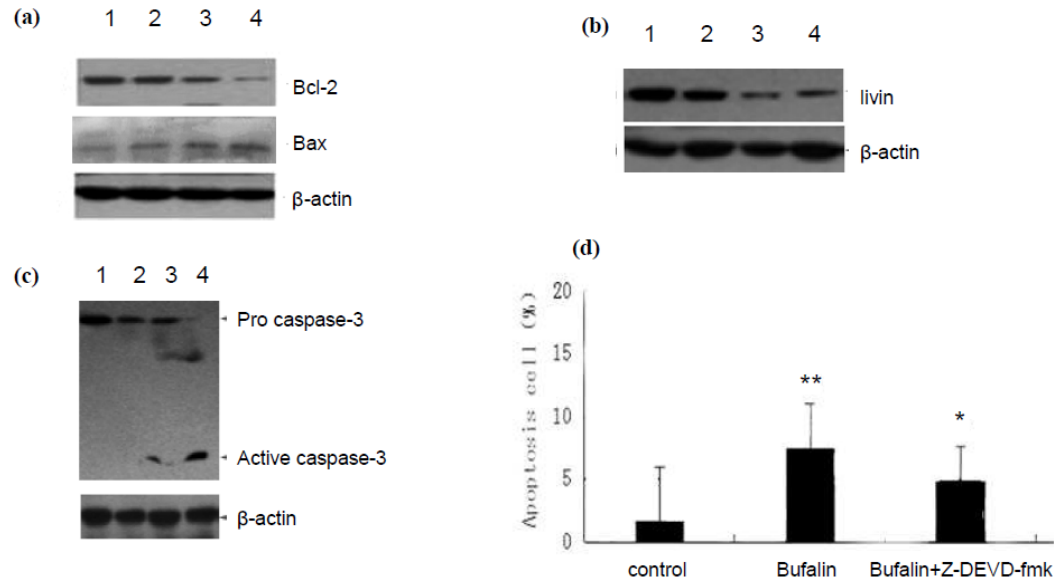
Figure 3. Bufalin regulates the expression of apoptosis related proteins in A549 cells. ( a ) Western blot analysis of Bcl-2 ad Bax protein level in A549 cells treated with 100 nmol/L bufalin for different time. ( b ) Western blot analysis of livin protein level in A549 cells treated with 100 nmol/L bufalin for different time. ( c ) Western blot analysis of the levels of pro-caspase-3 and activated Caspase-3 in A549 cells treated with 100 nmol/L bufalin for different time: 1. 0 h; 2. 12 h; 3. 24 h; 4. 48 h. β -actin served as loading control. Shown are representative blots from three independent experiments with similar results. ( d ). A549 cells were treated with vehicle, 100 nmol/L bufalin alone or plus Z-DEVD-fmk and the apoptosis was examined by PI staining and flow cytometry analysis. Data were derived from three independent experiments.* P <0.01 vs. bufalin alone; * P <0.01 vs.